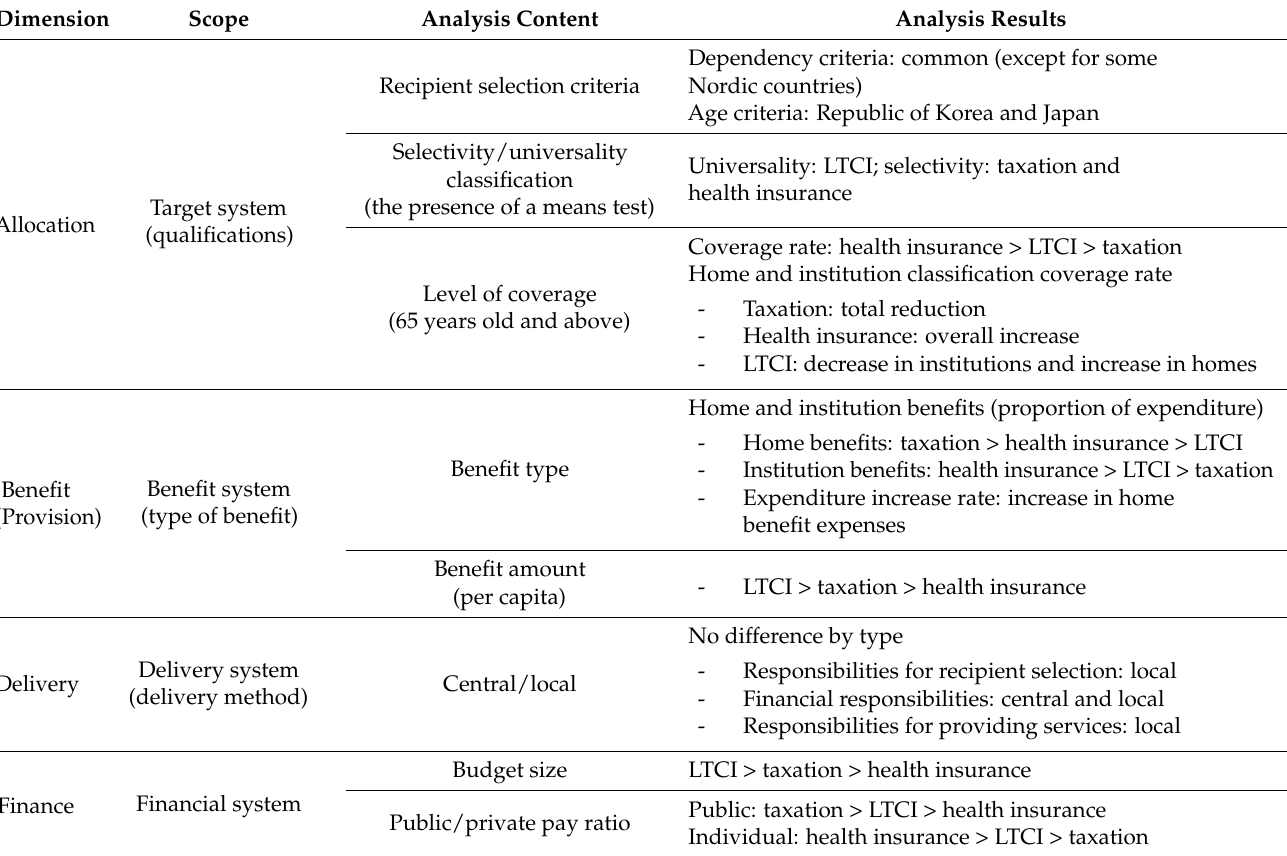
Table 8. Research